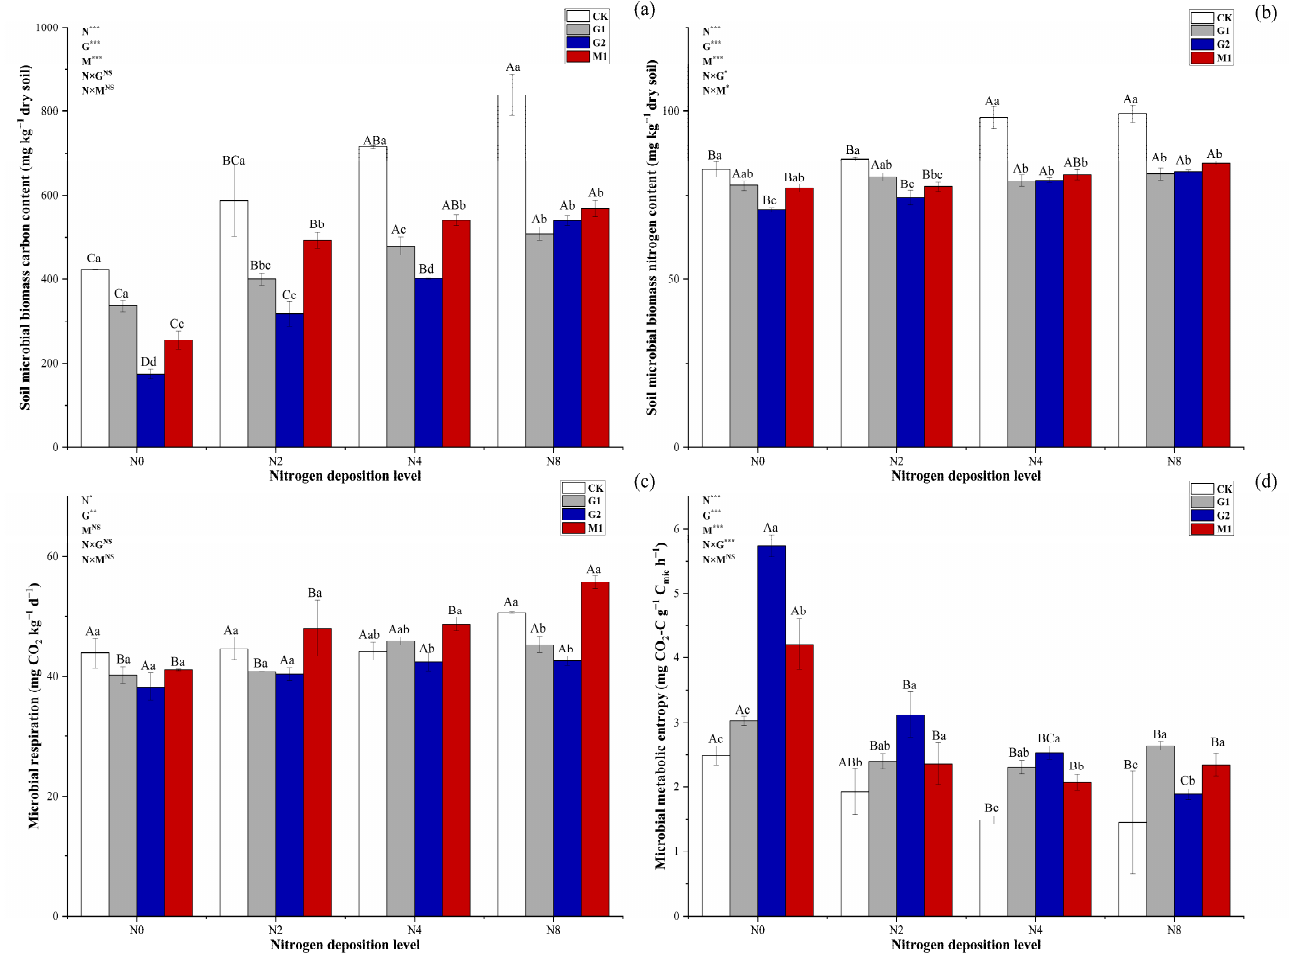
Figure 2. Effects of grazing sheep (G1, G2) and mowing (M1) on soil microorganisms at different nitrogen deposition levels (N0, N2, N4, N8); ( a ) soil microbial biomass carbon; ( b ) soil microbial biomass nitrogen; ( c ) microbial respiration; ( d ) microbial metabolic entropy. Different lowercase letters indicate significant differences among different treatments under the same nitrogen deposition level ( p < 0.05); different capital letters indicate significant differences among different nitrogen deposition levels under the same treatment ( p < 0.05). Significant effects of treatments are marked with an asterisk. Single, double, and triple asterisks indicate the significance levels at p < 0.5, <0.01, and <0.001, respectively, and NS indicates no significant difference.